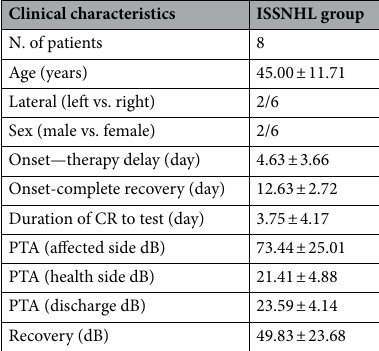
Table 1. Clinical characteristics of ISSNHL group. CR complete